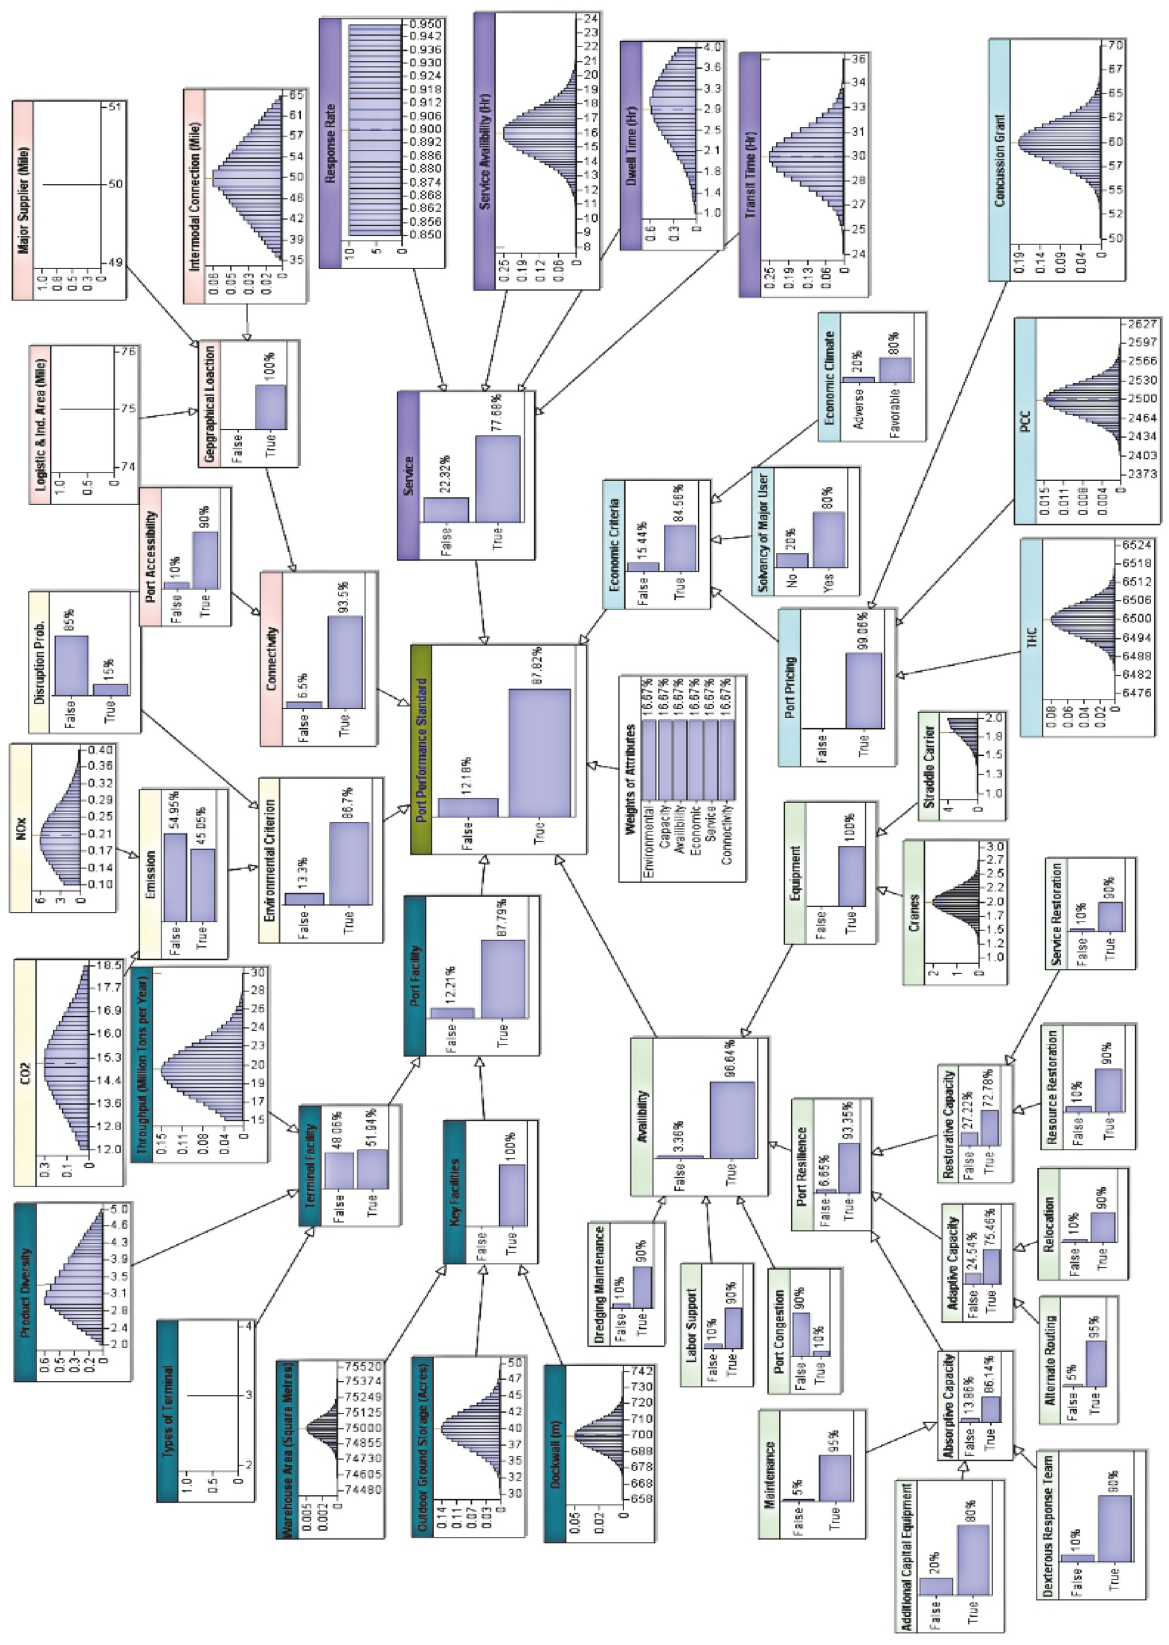
Figure 3: Base model of the Bayesian Network for measuring PPI of inland